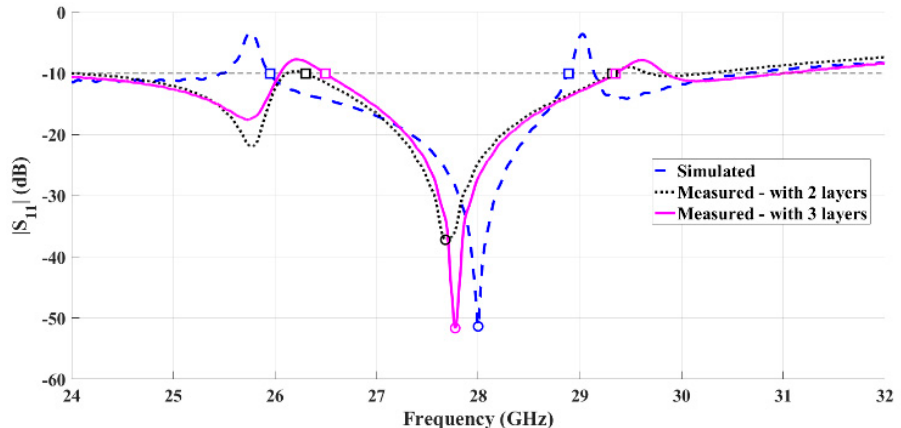
Figure 10. Comparison between simulated and measured reflection coefficient of the fabricated horn antennas using conductive paint, after applying sanding process.